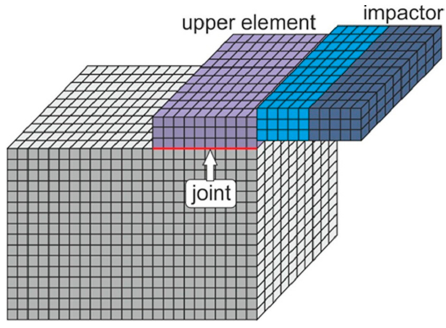
Figure 5. Model of the block sample, dynamically loaded .